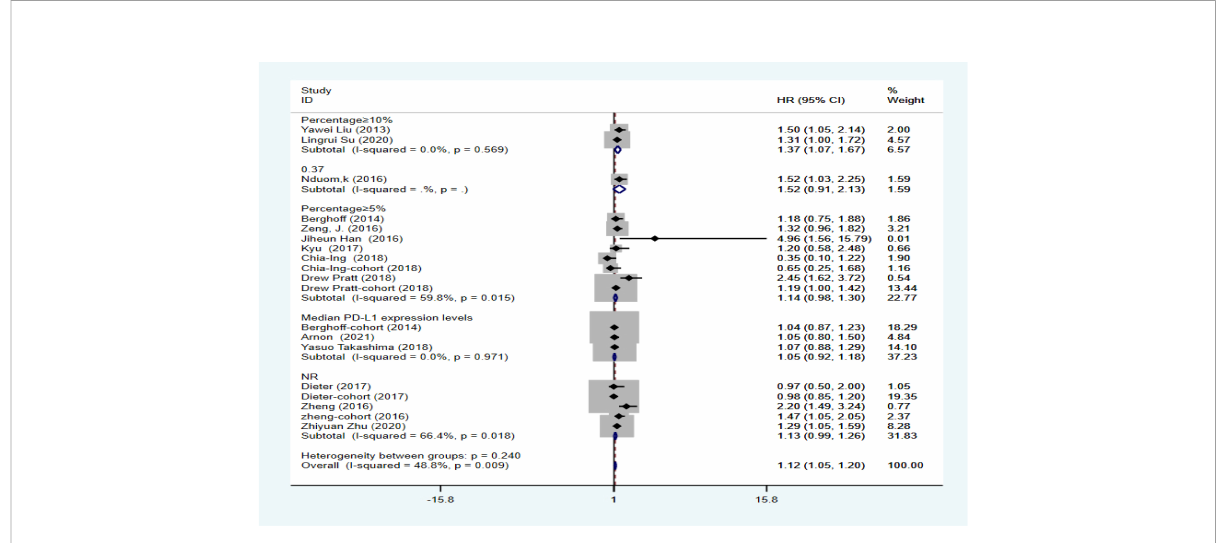
FIGURE 3 Analysis of subgroups with different cutoff values of PD-L1.